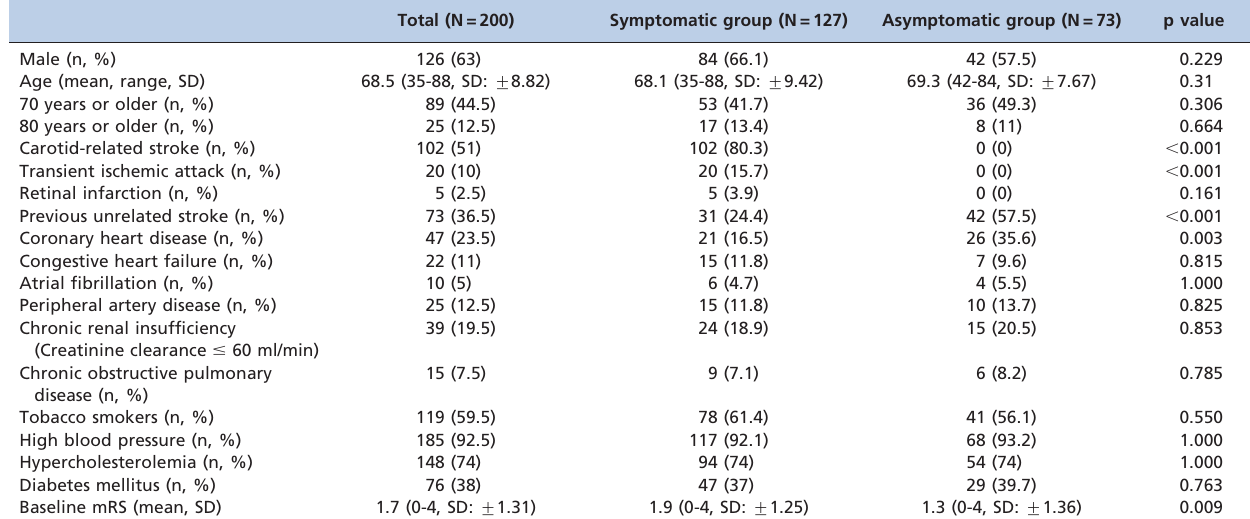
Table 2 - Patients’ baseline clinical data in each group.